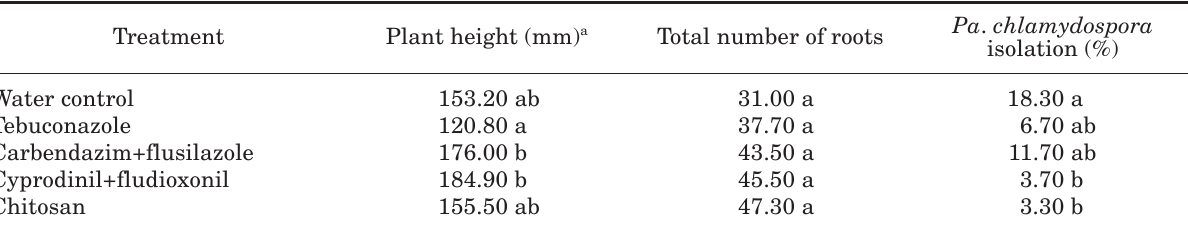
Table 5. Effects of chitosan and fungicides on grapevine plants cv. Castelão (plant height and total number of roots) grown in substrate infested by Phaeomoniella chlamydospora and on fungal percent isolation.